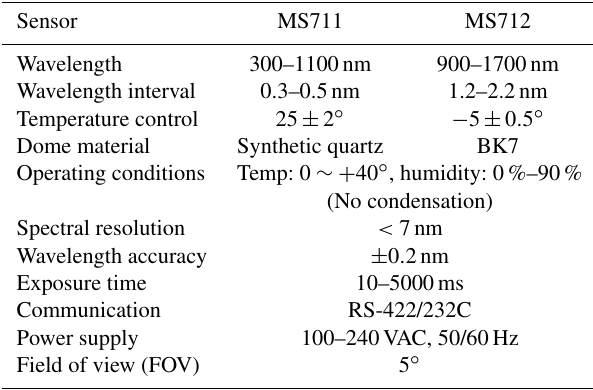
Table 1. Specifications of EKO MS711 and MS712 spectrora-